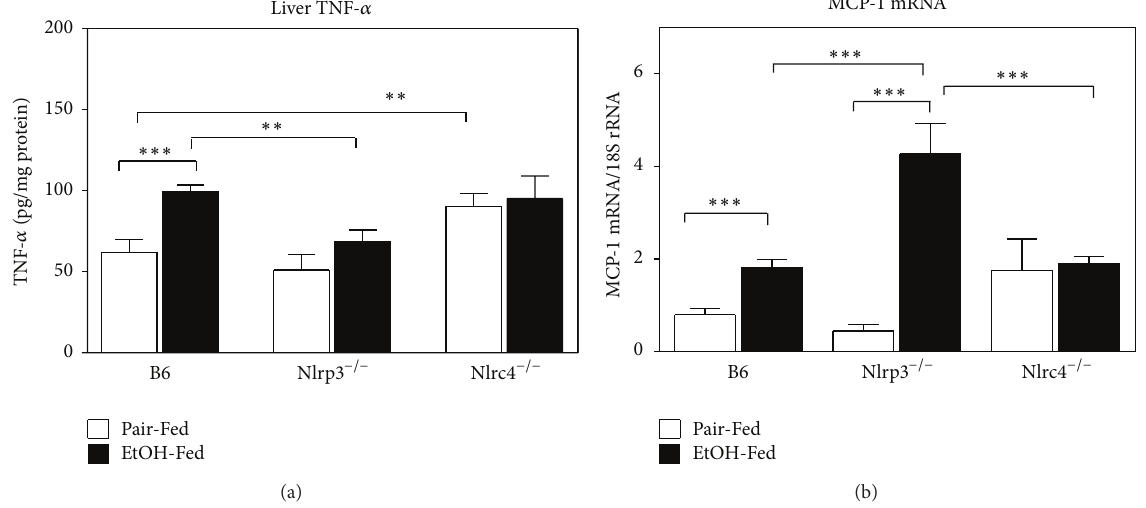
Figure 5: Expression of hepatic TNF- 𝛼 . Protein was isolated from livers of C57BL/6J (B6), Nlrp 3 −/− , and Nlrc 4 −/− mice fed Lieber-DeCarli ethanol-containing diet (EtOH-Fed) or pair-fed controls (Pair-Fed). Expression of hepatic TNF- 𝛼 was measured. The values are the means ± SEM and normalized with protein concentration in the homogenate for 𝑛 = 4 –6 mice per group. Values represent the mean ± SEM with ∗∗ 𝑃 < 0.05 , ∗∗∗ 𝑃 < 0.001 by Student’s 𝑡